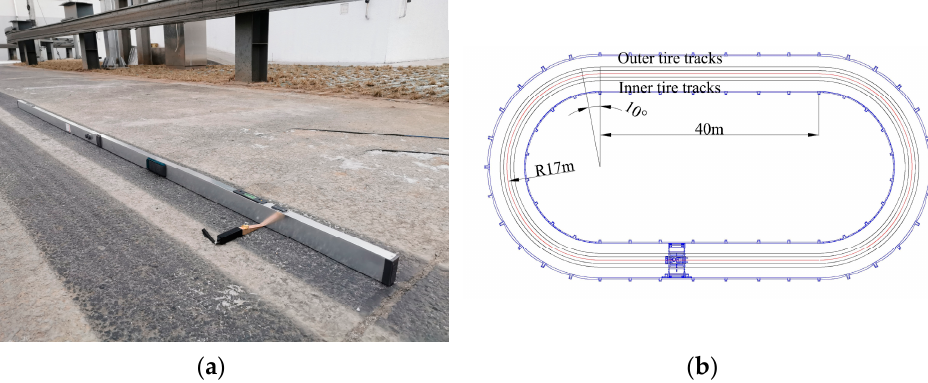
Figure 12. Measurement of road roughness. ( a ) 3 m Ruler and Feeler Gauge. ( b ) Circular Test Road. The 3 m ruler does not directly obtain the IRI or PSD value but the elevation h of the feeler gauge. The Ministry of Transport of the People’s Republic of China has given the conversion relationship between IRI and feeler height h as in Equation (9).